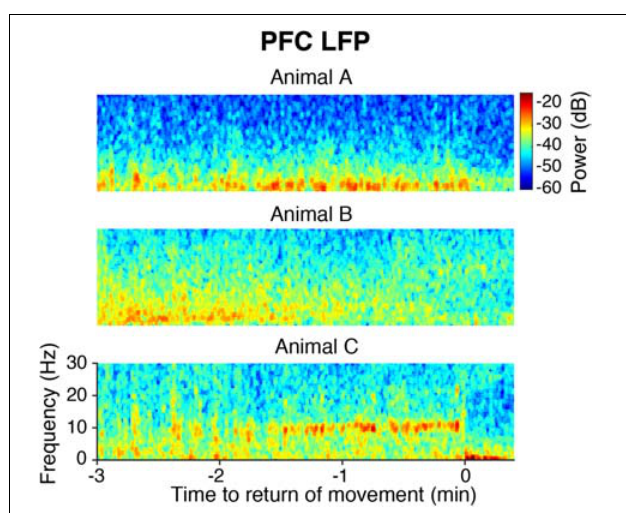
FIGURE 6 | Spectrograms of the PFC LFP from three animals aligned to ROM.